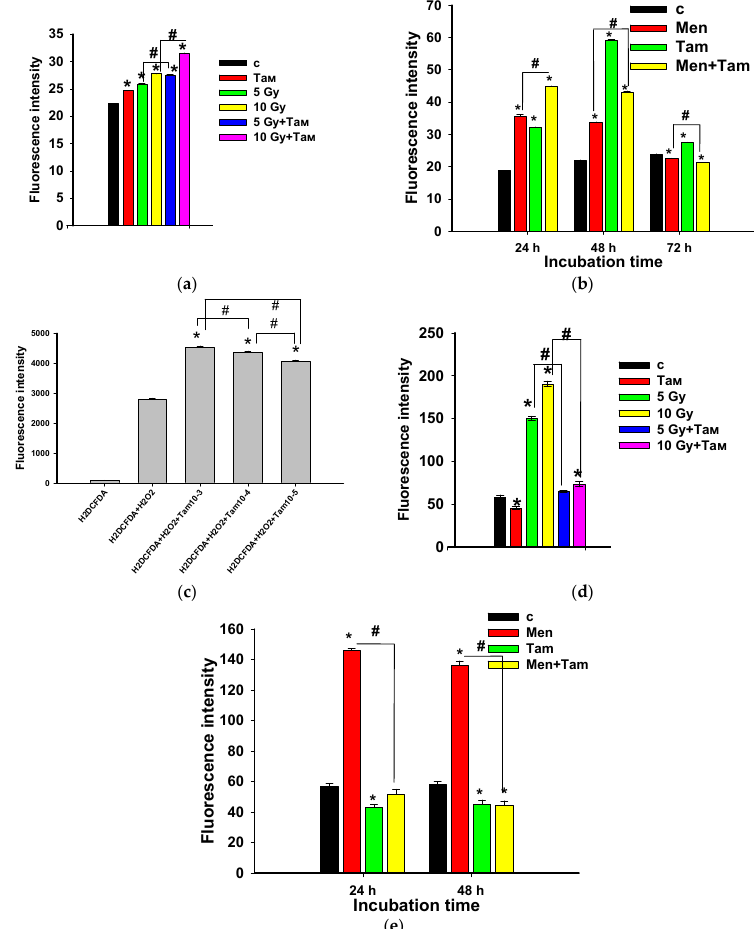
Figure 8. Tameron-mediated catalysis of H2DCFDA oxidation in vivo and in vitro. ( a ) Effect of Tameron (Tam) on DCF fluorescence in intact and 5 and 10 Gy-irradiated worms. ( b ) Effect of Tameron, menadione (Men), and Tameron-menadione combination on DCF fluorescence in planarians after 24, 48, and 72 h. ( c ) Tameron catalyzes H2DCFDA oxidation by H 2 O 2 in a concentration-dependent manner. ( d ) The effect of Tameron as a ROS scavenger in planarian bodies after X-ray exposure, revealed with CellROX ® Green dye. ( e ) Effect of Tameron as a ROS scavenger in planarian bodies after menadione exposure, revealed using CellROX ® Green dye. c—non-treated control, Tam—Tameron, Men—menadione. * p < 0.001 (difference from control), # p < 0.001 (difference from group without Tameron treatment). Data are presented as mean ±